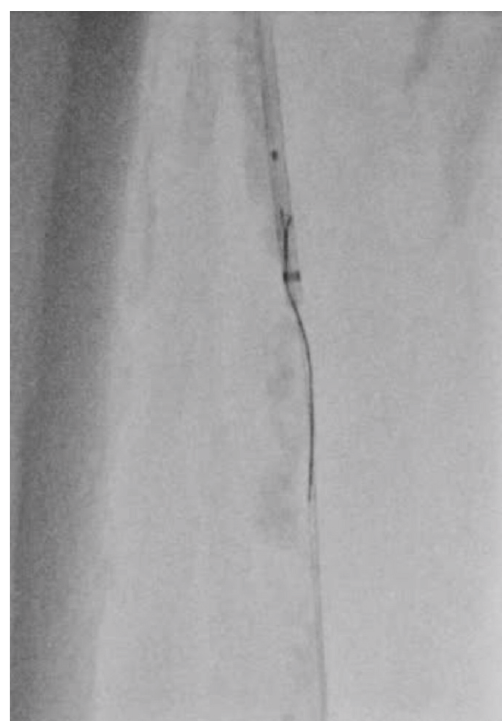
Figure 2: Rendezvous technique. The retrograde wire progresses into the antegrade child catheter.